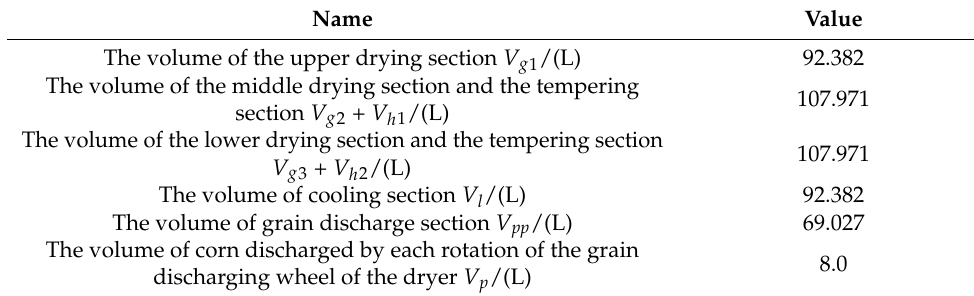
Table 11. The characteristics of the dryer.